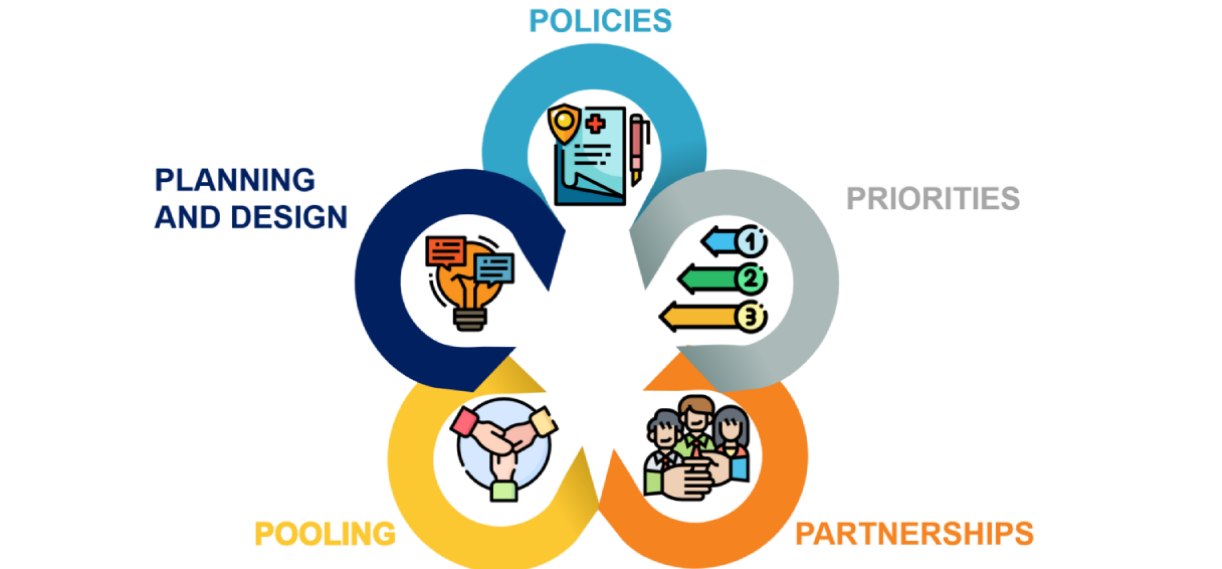
Figure 1. Ingredients to achieve sustained benefits through digital